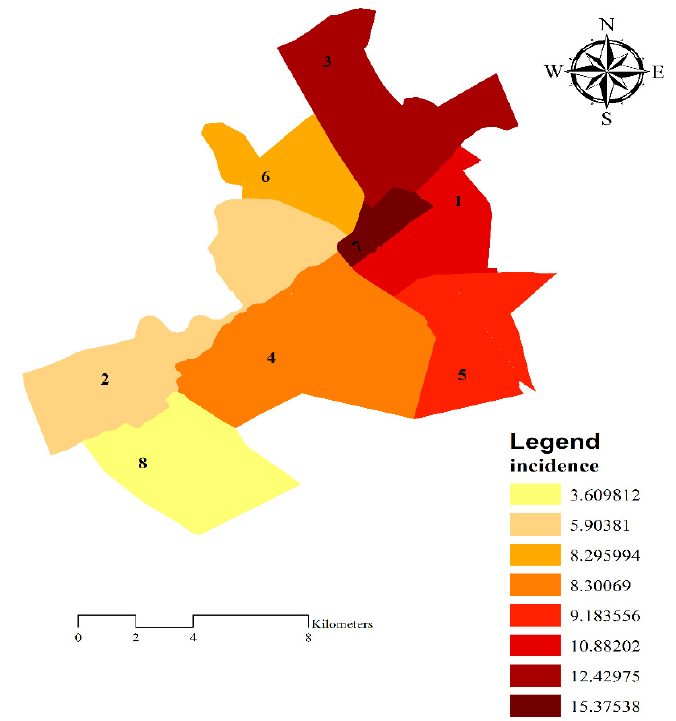
Figure 4. The incidence rate in municipality districts. Table 5. results of ANOVA (LSD) about the differences between group means of district 7 with other municipality districts in terms of awareness and performance.